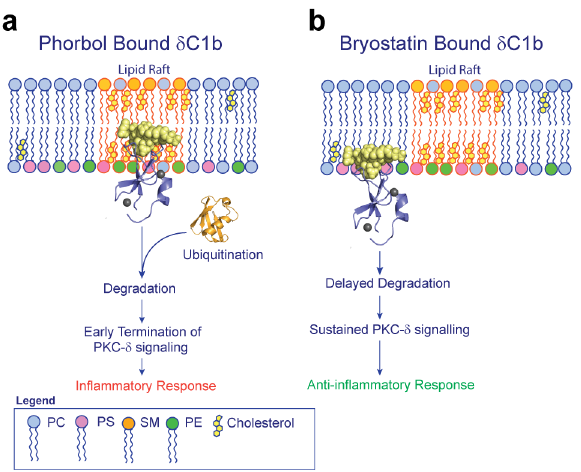
Figure 7. Schematic representation of the lipid raft hypothesis of PKC- δ modulation by phorbol and bryostatin. ( a ) Binding of phorbol results in deeper insertion within the membrane and contacts between PKC- δ and cholesterol are established. These contacts result in translocation of PKC- δ to cholesterol-rich lipid rafts, where ubiquitination occurs and rapid proteasomal degradation of PKC- δ ensues after initial activation [74]. ( b ) Binding of phorbol on the other hand results in a shallower binding topology and precludes the interaction between PKC- δ and cholesterol, limiting the trans- location of PKC- δ to lipid rafts. Disparate localization of PKC- δ from E3 ligases results in prolonged PKC- δ signaling and therefore an alteration to the downstream transcriptional profile.